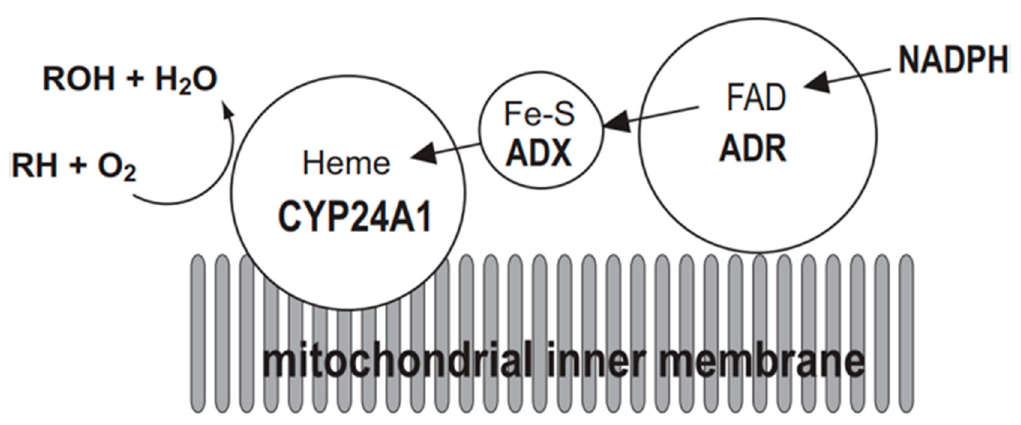
Figure 2. Mitochondrial electron transport chain of CYP24A1. CYP24A1-dependent mono-oxygenase activity requires the electron transfer from NADPH via NADPH-adrenodoxin oxidoreductase (ADR) and adrenodoxin (ADX) to the heme iron of CYP24A1 situated on the inner membrane of mitochondria. RH represents substrate of CYP24A1.